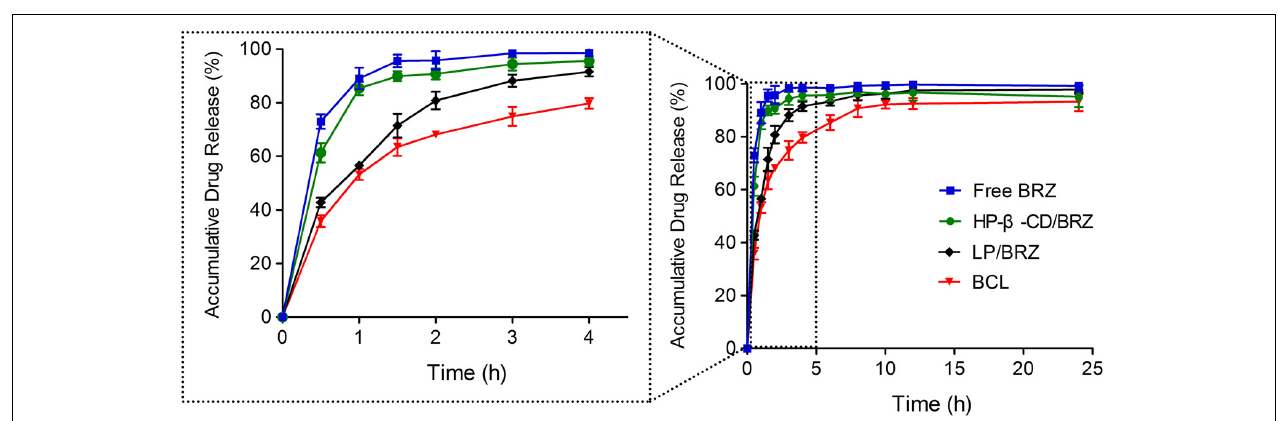
FIGURE 5 | In vitro release profiles of BRZ from BRZ solution (free drug), HP- β -CD/BRZ, LP/BRZ, and BCL at 37 ◦ C in simulated tear fluid. Data are expressed as mean ± SD ( n = 3).